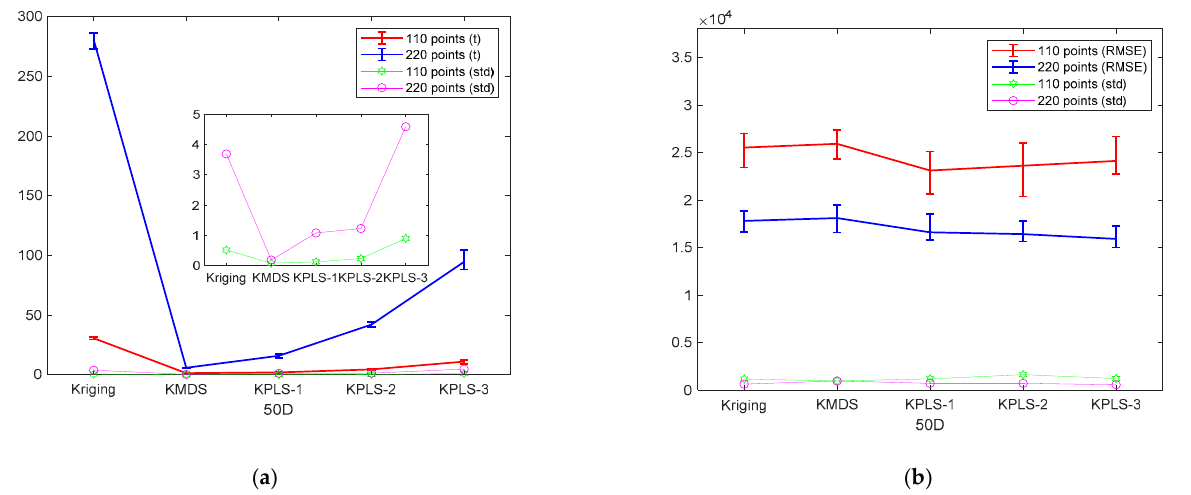
Figure 8. ( a ) Modeling time and its standard deviation for the 50D Rothyp function. ( b ) RMSE and its standard deviation for the 50D Rothyp function.